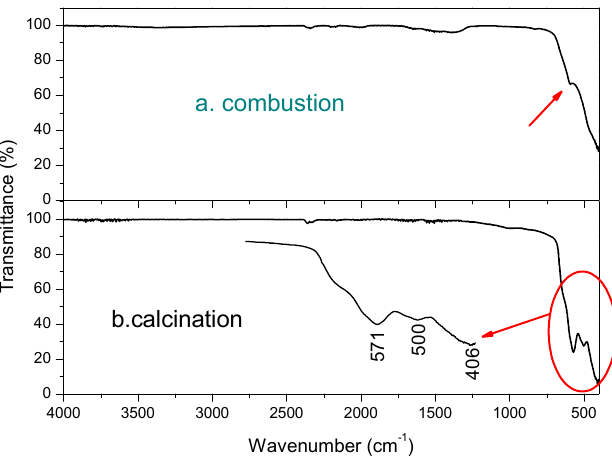
Figure 3. FT-IR spectra of NiMn2O4 powder after combustion ( a ) and calcination ( b ). Photoelectron peaks corresponding to C, O, Mn and Ni were identified in the recorded survey XPS spectrum, as previously noted for spinel nickel manganite [36]. Oxidation states of elements were analyzed [39] and the recorded high energy resolution XPS spectra for Mn 2p and Ni 2p are shown in Figure 4. The Mn 2p spectra consisted of doublet Mn 2p 3/2 and Mn 2p 1/2 separated by 11.7 eV. This value of spin-orbit splitting was previously noted for spinel nickel manganite [40,41]. Mn 2p 3/2 spectra were deconvoluted into three components: peak Mn-1 at 639.2 eV assigned to Mn 2+ , peak Mn-2 at 641.3 eV assigned to Mn 3+ and peak Mn-3 at 643.5 eV assigned to either a satellite peak of Mn or to Mn 4+ . The relative portion of Mn-1 (Mn 2+ ) peak inside the total Mn 2p 3/2 peak was 9.8%. The presence of Mn in all three valences has also been previously noted for cubic spinel